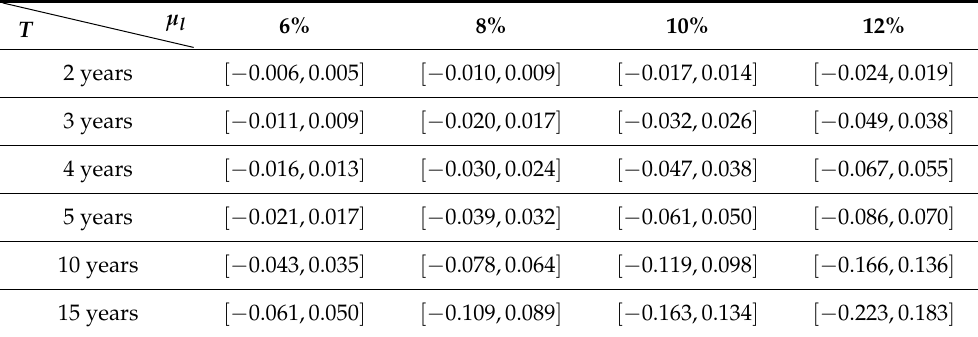
Table 1. Optimal investment change vector for a portfolio containing an ETF and MF as a function of the investment horizon T and the expected ETF return µ l